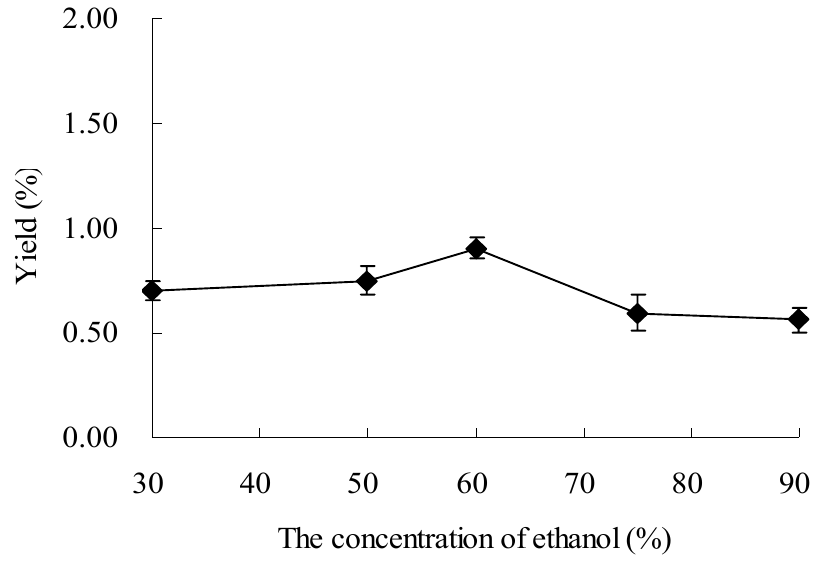
Figure 1. Effect of ethanol concentration on the extraction yield.